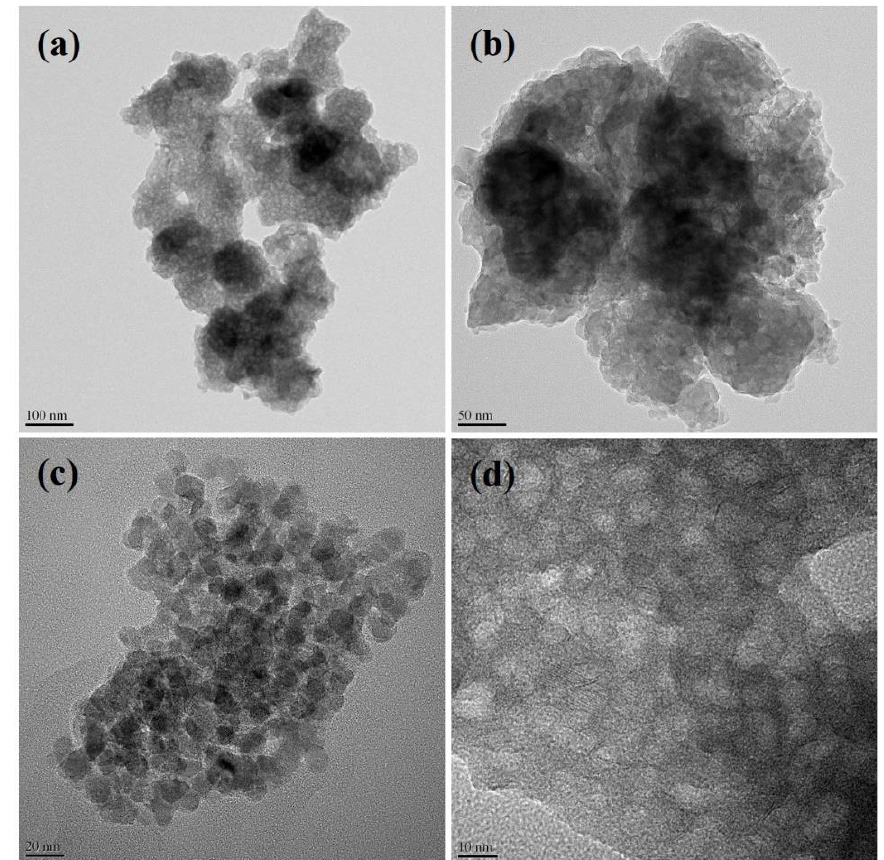
Figure 3. ( a – d ) SEM images of NiCdTiO 2 nanocomposite. Figure 3. ( a–d ) SEM images of NiCdTiO 2 nanocomposite.